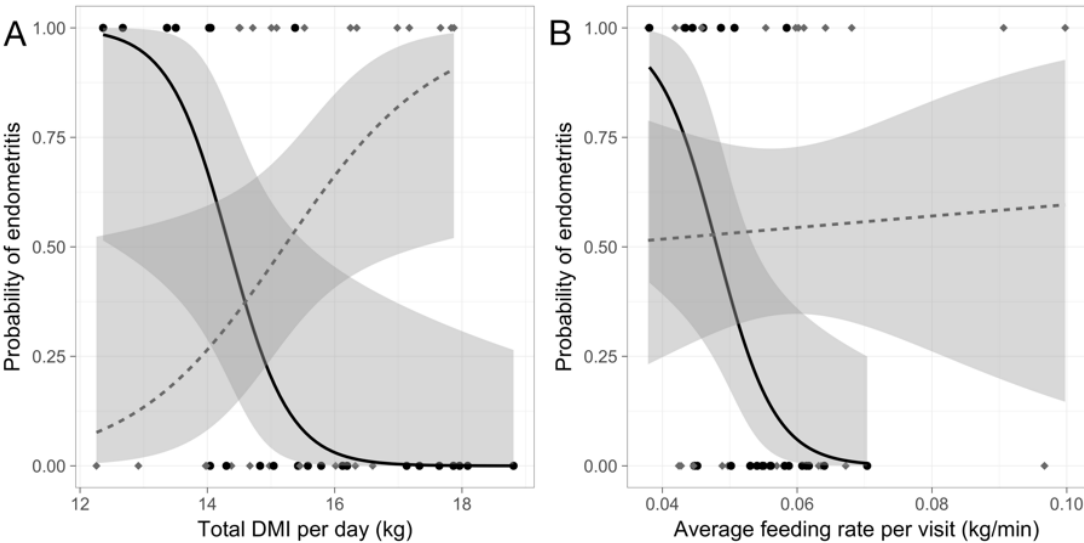
Figure 1. The probability postpartum cytological endometritis given individual differences in ( A ) the total DMI per day (kg) and ( B ) the average rate of DMI per visit (kg/min) during the four weeks before calving in Holstein dairy cows managed in a predictable and non-competitive social environment (black solid line and circles; n = 16 healthy, n = 7 developed endometritis) or an unpredictable and competitive social environment (gray dashed line and diamonds; n = 11 healthy, n = 13 developed endometritis). Gray bands indicate 95% confidence.